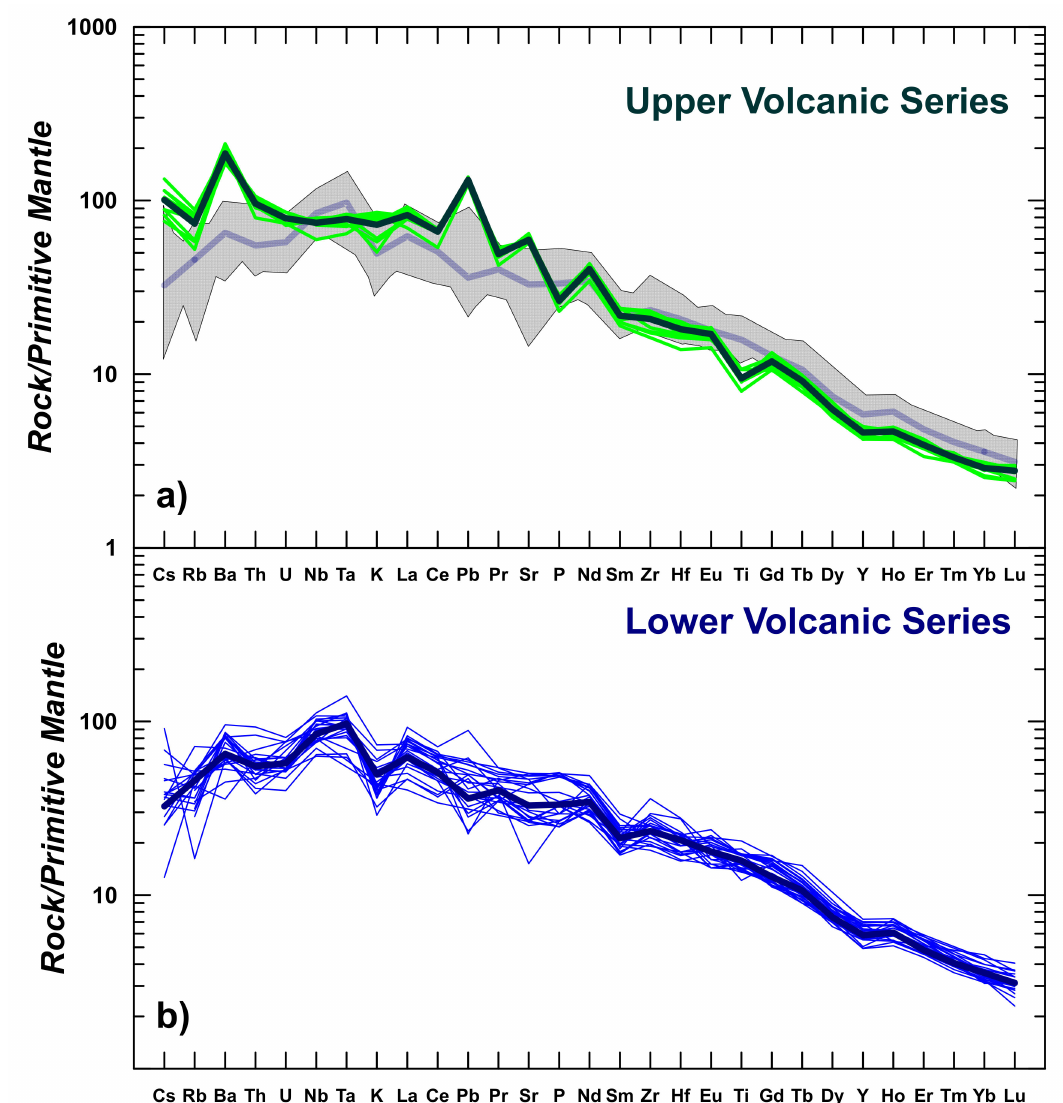
Figure 10. Primitive mantle normalized trace element abundance patterns for Christmas Island lava series; ( a ) Upper volcanic series—thin green lines, lava with >9 wt% MgO, thick dark green line— average; pale blue thick line is the average pattern for LVS lava with >9 wt% MgO for comparison; gray field encompasses the range in patterns for the LVS lava in panel b; ( b ) Lower volcanic series— thin blue lines, lava with >9 wt% MgO, thick dark blue line—average. Primitive mantle normalizing values from